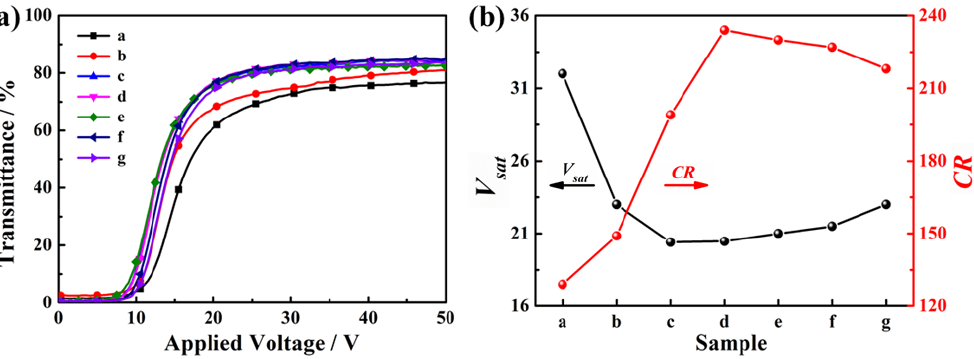
Figure 6. ( a ) The curve of samples a – g transmittance with voltage, ( b ) V sat and CR of a – g sample.